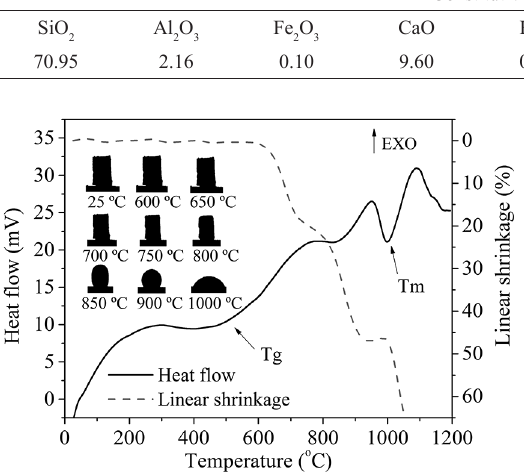
Figure 1: Linear shrinkage (also showing pictures of specimen tested in different temperatures) and DSC curves of the TGB.